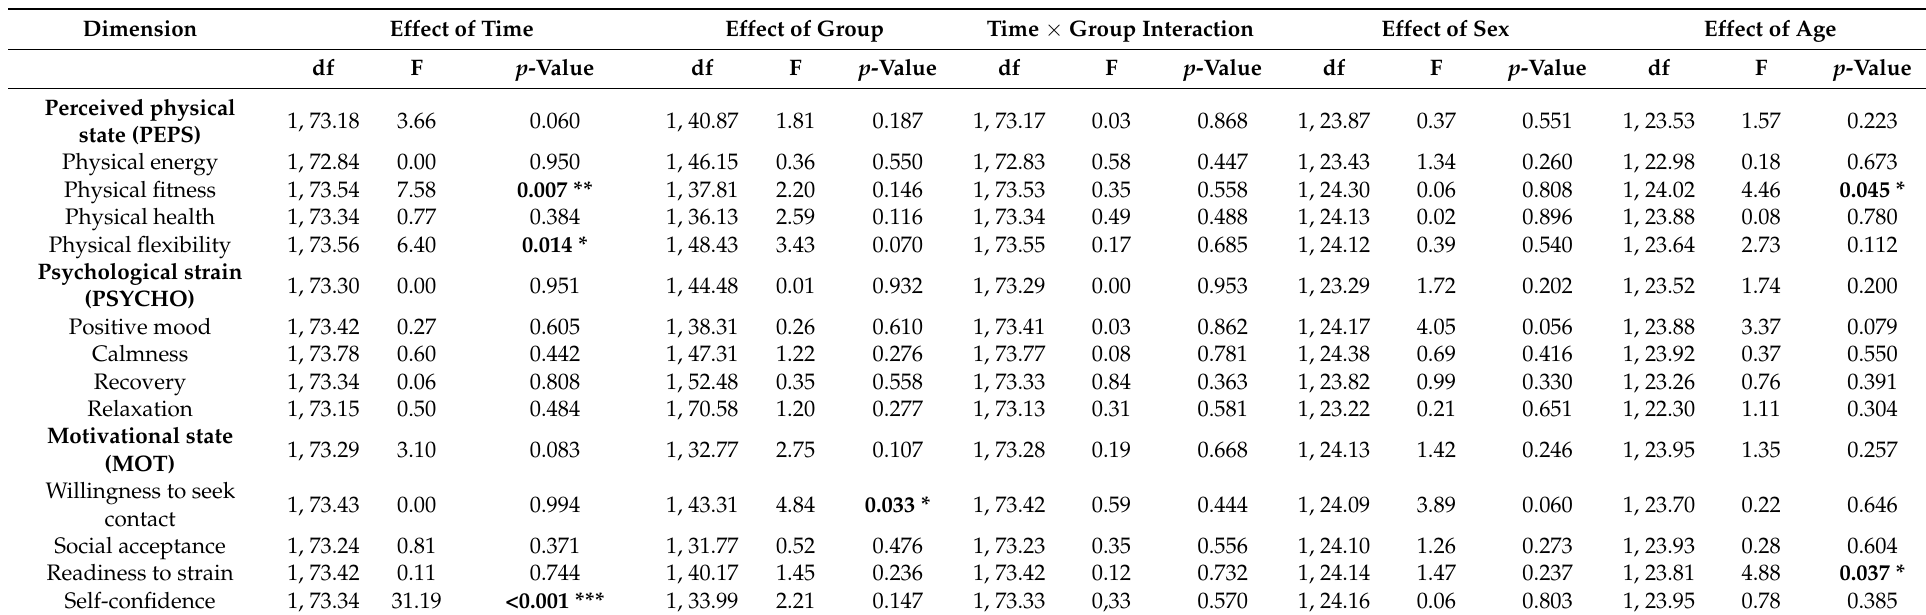
Table 3. Statistics of the MoodMeter ®